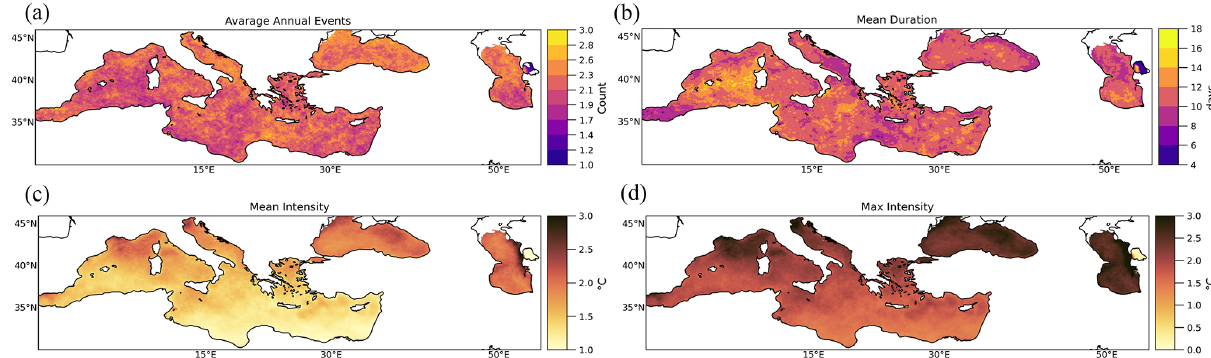
Figure 5. MHW characteristics for each grid cell. (a) Average number of annual events. (b) Mean duration. (c) Mean intensity. (d) Maximum intensity. The color schemes used in this figure are produced using the “Scientific colour maps” package (Crameri et al., 2020).